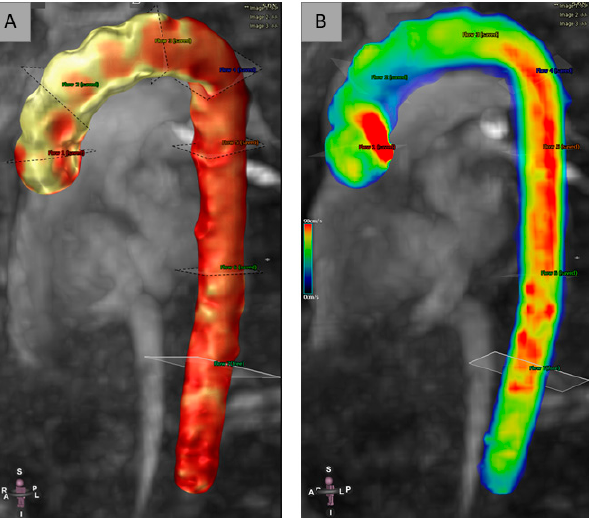
Figure 1. Segmentation with centerline: ROIs location in the full thoracic aorta ( A ); Velocity represented on colorimetric scale ( B ).